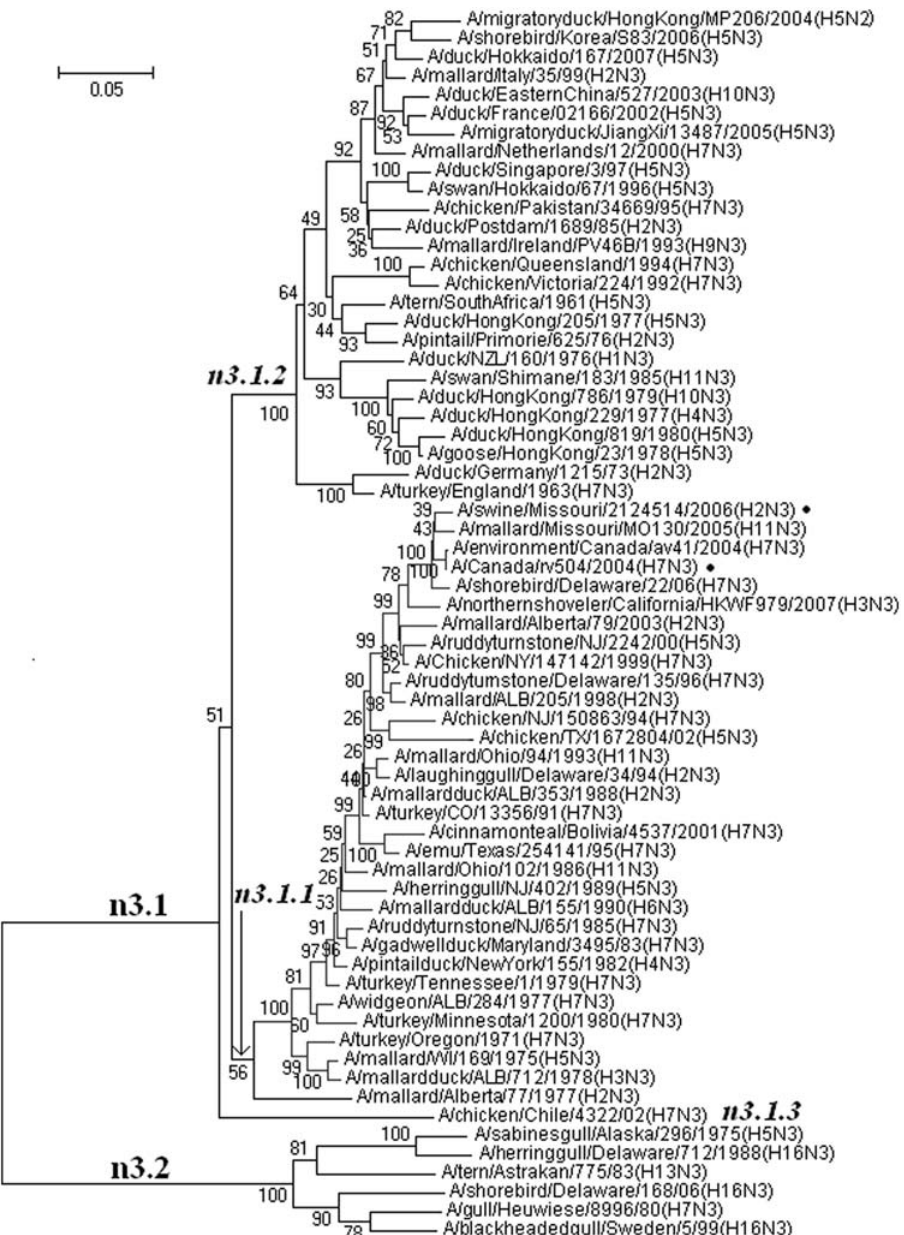
Figure 12. The panorama diversity of subtype N3 influenza viruses which could be divided into two lineages. Lineage n3.1 was further divided into 3 sublineages. Some viruses in sublineage n3.1.2 isolated from humans or pigs were marked with ‘‘ N ’’. Bootstrap values were given at relevant nodes.